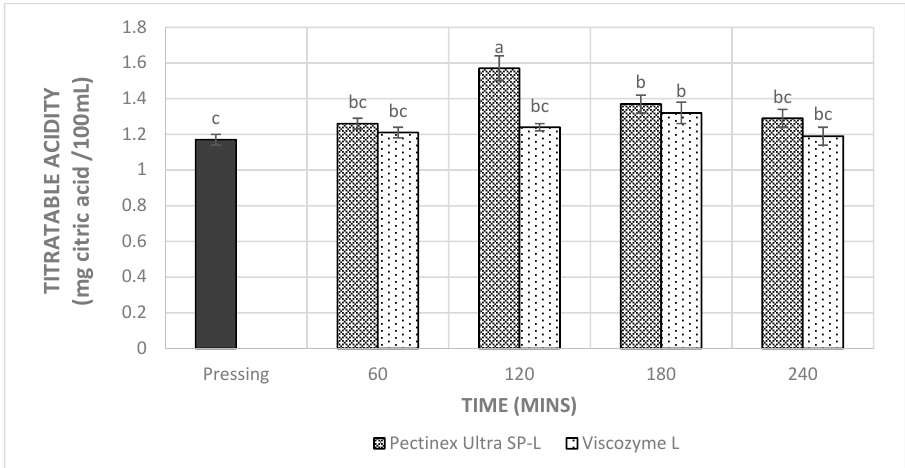
Figure 3. The effects of enzyme treatments on the titratable acidity of mulberry juice. The values are mean ± SD ( n = 3). Means sharing different letters are significantly different ( p < 0.05).